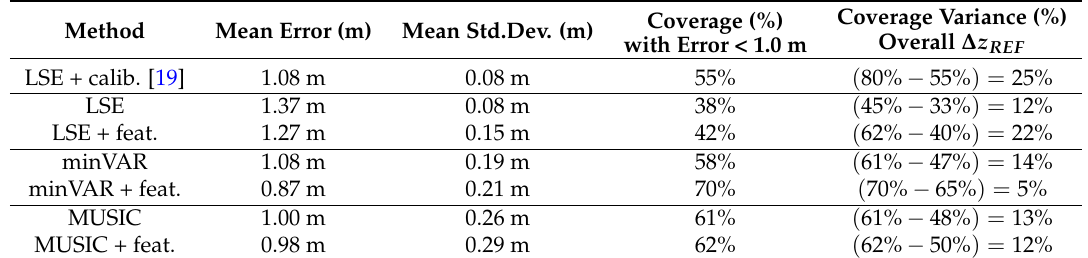
Table 3. Localization Estimation Result Comparison (Overall Area [35 m 2 ]) @ z REF = 1.10